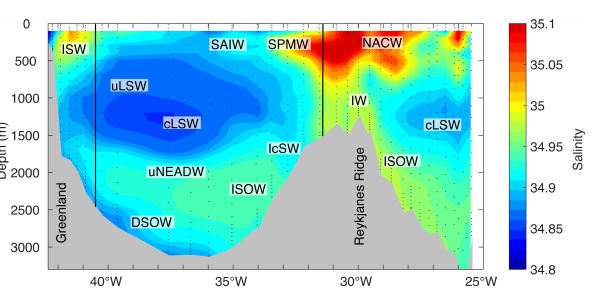
Figure 3. Vertical cross section through the Irminger Sea showing interpolated salinity based on the 1991 cruise data (06MT19910902). The approximate location of the main water masses of the eOMP analysis, explicitly shown in Ap- pendix B, is illustrated: Subarctic Intermediate Water (SAIW), Intermediate Water (IW), classical and upper Labrador Sea Water (cLSW and uLSW), Denmark Strait Overflow Water (DSOW), up- per North-east Atlantic Deep Water (uNEADW), Iceland–Scotland Overflow Water (ISOW), Icelandic Slope Water (IcSW), Irminger Sea Water (ISW), Subpolar Mode Water (SPMW), North Atlantic Central Water (NACW). The longitudinal boundaries for the inventory estimates at 40.5 and 31.5 ◦ W are shown (black lines).